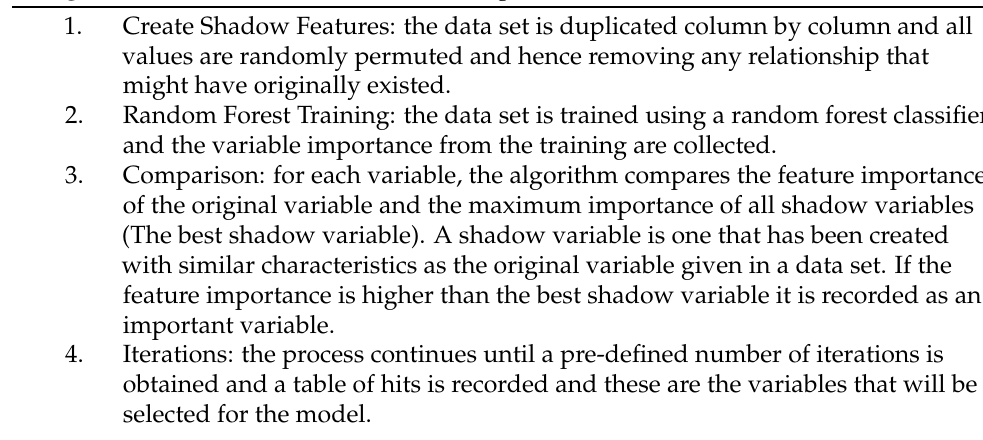
Algorithm 1: Boruta Variable Selection Algorithm